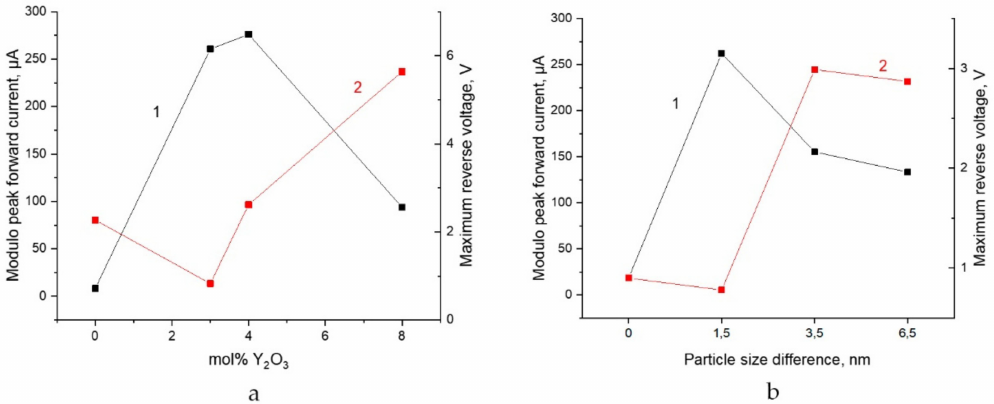
Figure 7. Dependence of the limiting values of forward current (curve 1) and reverse voltage (curve 2) at a humidity of 85% on the content of yttrium nanoparticles in the composition of the material ( a ) and the difference in particle diameters ( b